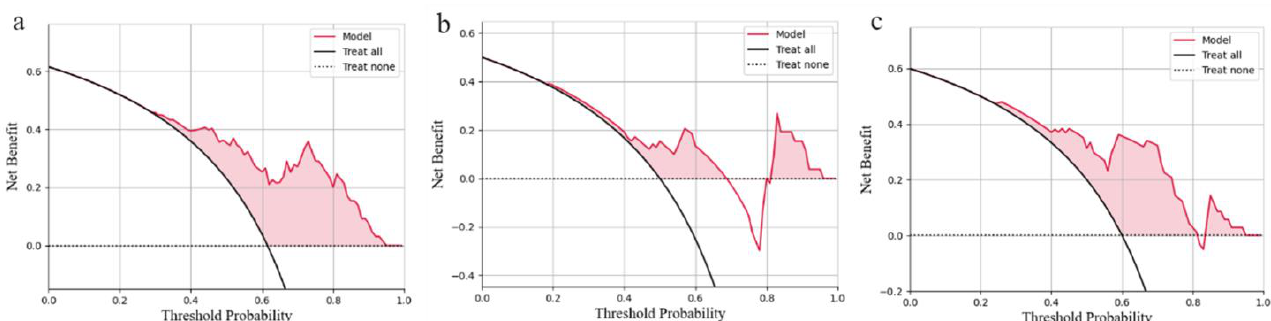
Figure 6. Decision Curve Analysis (DCA) of logistic regression model. ( a ): internal test set; ( b ): ex- ternal test set 1; ( c ): external test set 2.